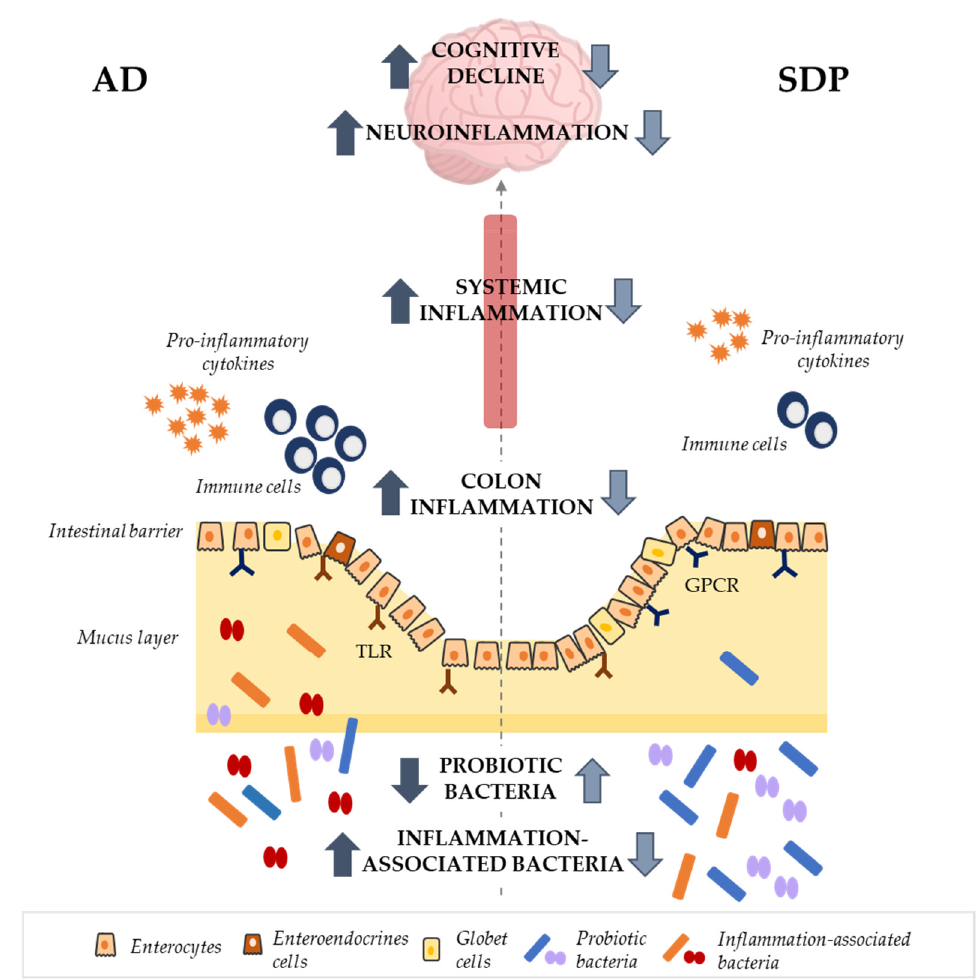
Figure 14. Schematic integrative representation of the effects of SDP supplementation on the gut − brain axis in an AD mouse model. Dietary supplementation with SDP promotes the growth of probiotic genera and reduces the levels of pathogenic genera. This is accompanied by a reduction in the intestinal permeability and local and systemic immune and inflammatory responses. These effects culminate in a reduction in neuroinflammation and an amelioration of the cognitive decline. AD, Alzheimer’s disease; GPCR, G protein-coupled receptors; SDP, spray-dried porcine plasma; TLR, toll-like receptor.